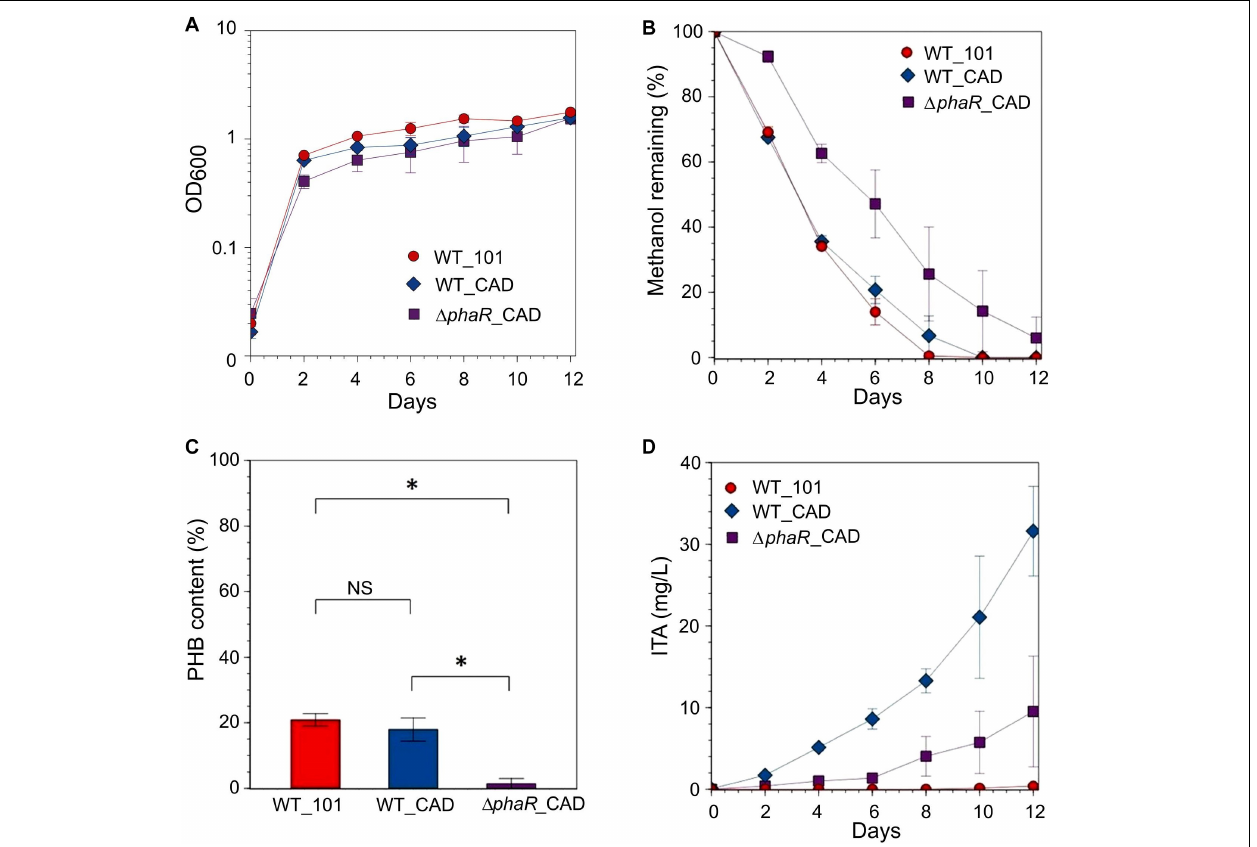
FIGURE 4 | Strains grown in HM medium supplemented with 240 mM methanol as the carbon source. (A) OD 600 , (B) methanol remaining, (C) PHB content (PHB weight/cell dry weight) measured at the final time point and (D) ITA concentration. Significant differences (Student’s t -test, p < 0.05) were observed in ITA concentration between WT_CAD and (cid:49) phaR _CAD at the final time point (day 12). Asterisk ( ∗ ) denotes statistically significant difference (Student’s t -test, p < 0.05), whereas NS denotes no statistically significant difference. Error bars represent one standard